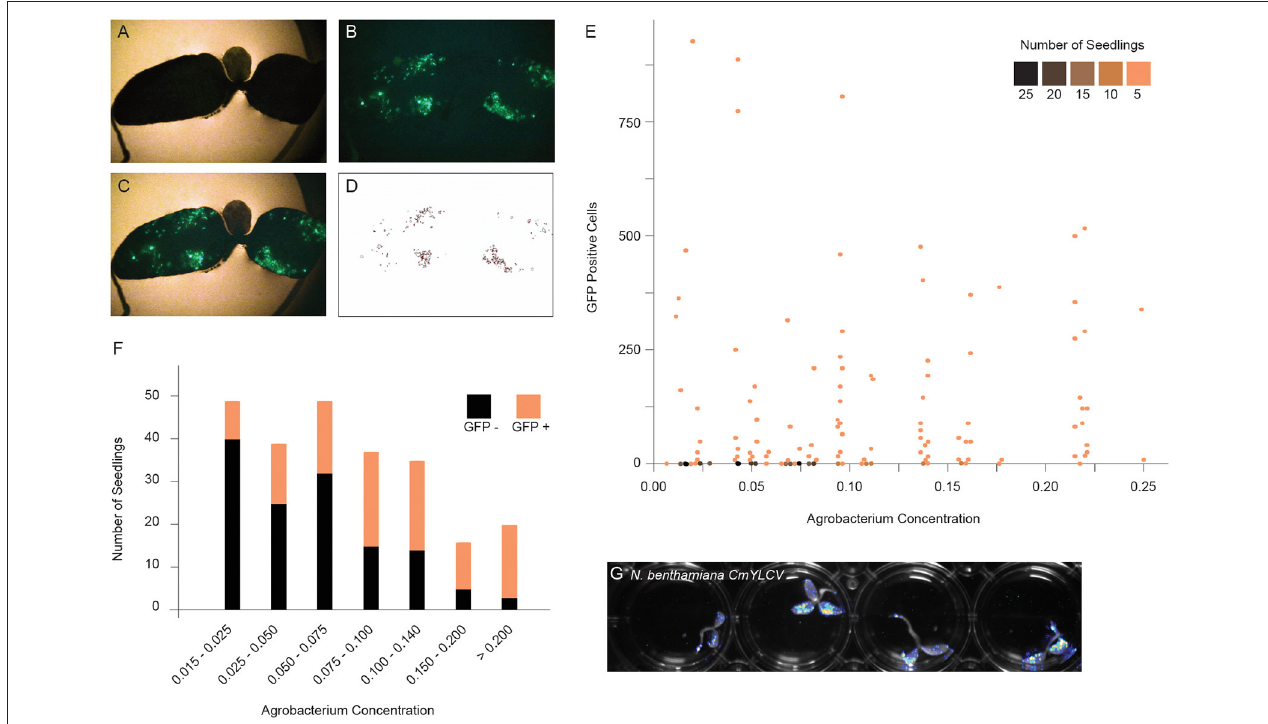
FIGURE 1 | Optimizing fast-TrACC conditions for N. benthamiana . To define the optimal co-culture conditions for gene transfer, constructs expressing GFP were delivered to N. benthamiana seedlings. After co-culture, seedlings were visualized for the presence of fluorescent signal. Bright field (A) and fluorescent images (B) were merged (C) , and the fluorescent signal was isolated over background (D) . Using these images, individual GFP positive sectors were counted. Seedlings were treated across a range of Agrobacterium concentrations, and the number of GFP positive sectors were tracked (E) . While seedlings with GFP positive sectors were observed at all bacterial concentrations, the number of negative seedlings was much higher at lower concentrations ( E,F , black). The Agrobacterium concentration of OD 600 = 0.09 represents the inflection point where an increasing percentage of seedlings showed fluorescence ( E,F , orange). While the trend continued beyond OD 600 = 0.18, there was a subsequent increase in tissue death beyond this concentration. In addition to fluorescent reporters, firefly luciferase can be delivered to N. benthamiana seedlings as illustrated here with the CmYVLC promoter (G) .